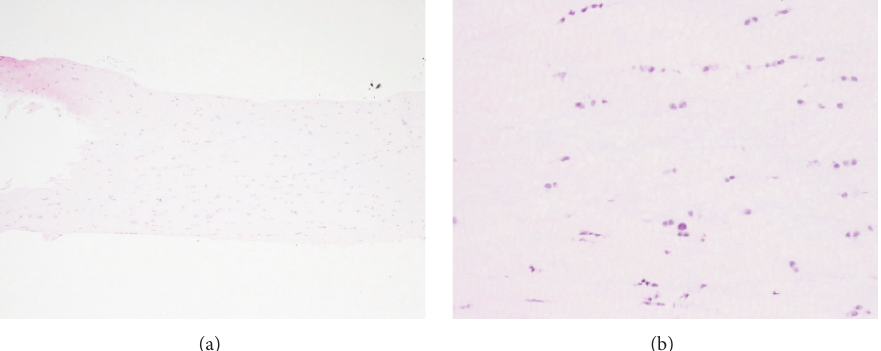
Figure 3: Histological findings of the second semicircular meniscus. No disorder was seen in the arrangement of collagen fibers, which were dense and parallel. Hematoxylin and eosin staining, × 40 (a) and × 100 (b).